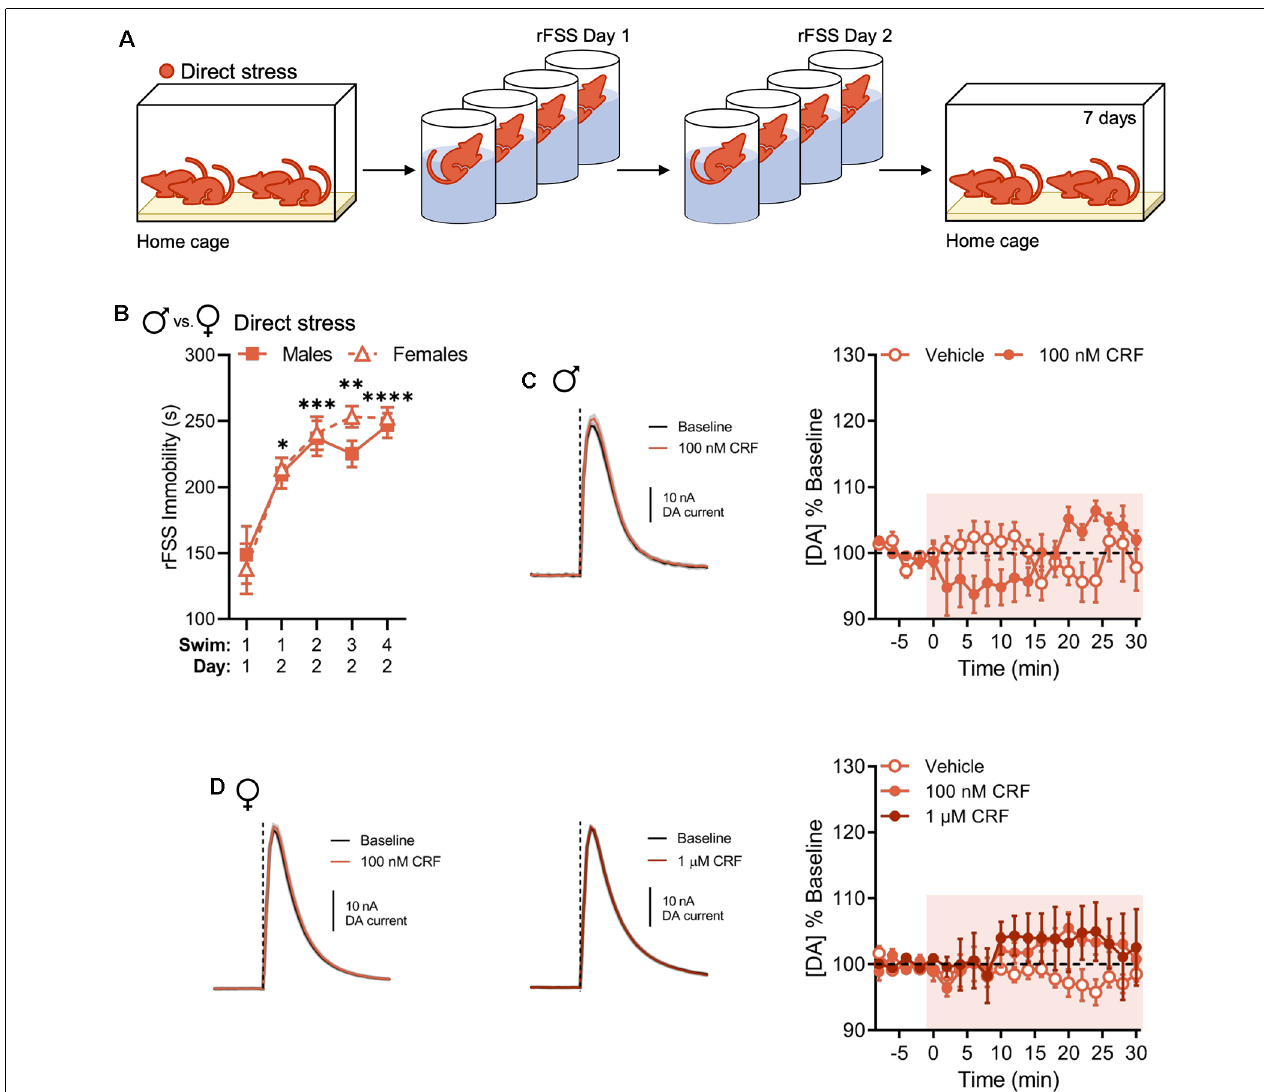
FIGURE 2 | Direct stress disrupts CRF-mediated dopamine release in the NAc 1 week after repeated forced swim stress (rFSS) exposure in males and females. (A) In the direct stress experimental group, mice were exposed to rFSS and tested 7 days later. (B) Cumulative time spent immobile for the first 5 min of Swim 1 on rFSS Day 1 and Swims 1–4 on rFSS Day 2 in males ( n = 6) and females ( n = 10) belonging to the direct stress group. (C) Representative dopamine release evoked by electrical stimulation (dashed line) before and after application of 100 nM CRF to a NAc brain slice (mean ± SEM for five consecutive stimulations, left) and baseline-normalized mean peak amplitude of electrically evoked dopamine release over time in response to vehicle ( n = 5) or 100 nM CRF ( n = 5) application to NAc slices (right) from directly stressed males 1 week after stress exposure. (D) Representative dopamine release evoked by electrical stimulation before and after application of 100 nM CRF (left) or 1 µ M CRF (middle) to a NAc slice (mean ± SEM for five consecutive stimulations) and baseline-normalized mean peak amplitude of electrically evoked dopamine release over time in response to vehicle ( n = 5), 100 nM CRF ( n = 5), or 1 µ M CRF ( n = 5) application to NAc slices (right) from directly stressed females 1 week after stress exposure. Error bars, SEM. ∗ P < 0.05, ∗∗ P < 0.01, ∗∗∗ P < 0.001, ∗∗∗∗ P < 0.0001 vs. rFSS Swim 1 Day 1